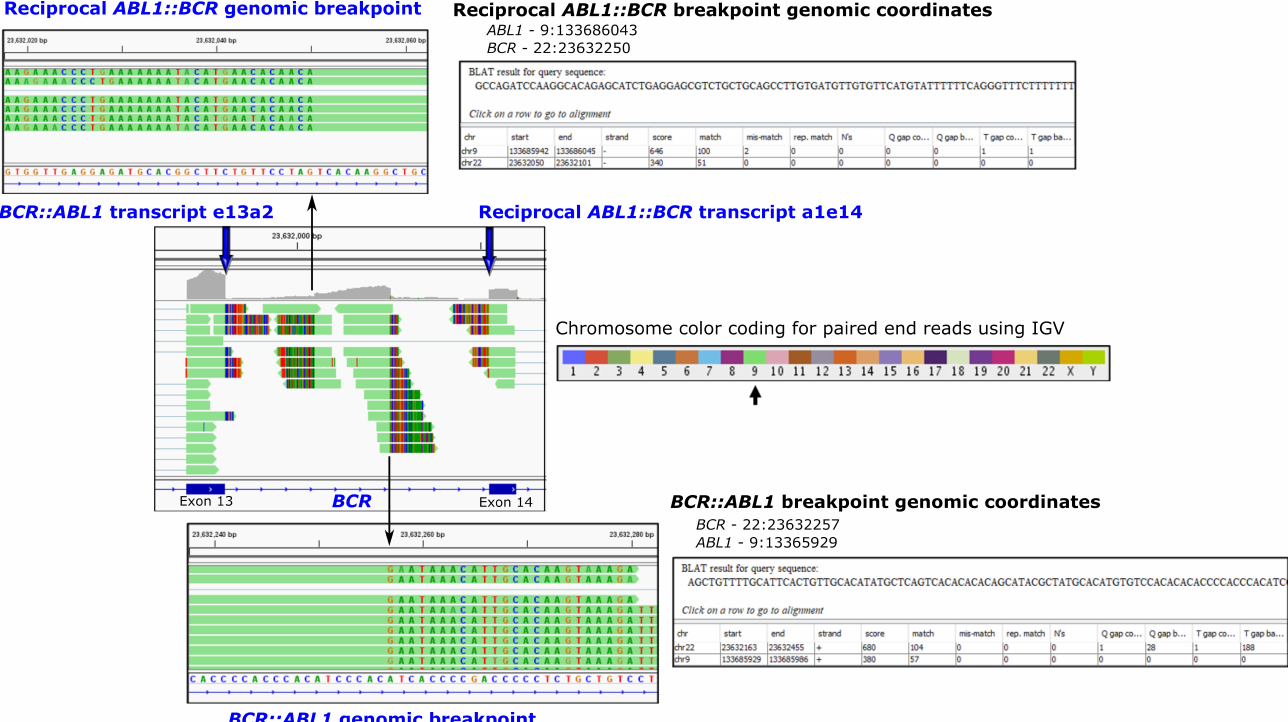
Figure 2. Fusion transcripts and the corresponding genomic breakpoints at base-pair resolution are detectable using next-generation sequencing. Shown is a segment of the BCR gene on chromosome 22 for a patient with the BCR::ABL1 fusion gene and CML where paired-end sequencing reads are visu- alised using the Integrative Genomics Viewer (IGV). RNA-seq using total RNA was performed [11]. Bioinformatic tools identify the rearrangements, and IGV allows a composite view of all fusions asso- ciated with the translocation between chromosomes 9 and 22. The multicoloured regions (chimeric reads) indicate that the sequence is derived from another location in the genome. The color-coded reads indicate that the sequence is derived from chromosome 9. Zooming into the BCR intronic region reveals the fusion breakpoints at base-pair resolution. Alignment of the chimeric reads using the BLAT function indicates the genomic coordinates of the partner read. Fusions include the primary disease-causing BCR::ABL1 oncogenic fusion transcript ( BCR exon 13 fused to ABL1 exon 2) and the corresponding intronic BCR::ABL1 genomic fusion. These rearrangements are located on the Philadelphia chromosome. The reciprocal rearrangements located on the derivative chromosome 9 are also detectable in the IGV composite view: the reciprocal ABL1::BCR fusion transcript ( ABL1 exon 1 fused to BCR exon 14) and the reciprocal ABL1::BCR genomic fusion. Genome build